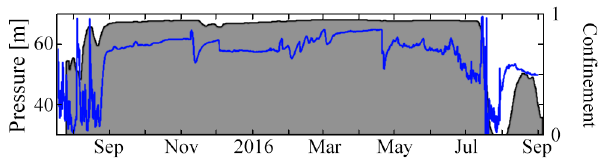
Figure 15. Confinement data (grey) and pressure (blue) for one of the digital sensors in Fig. 9c from July 2015 to September